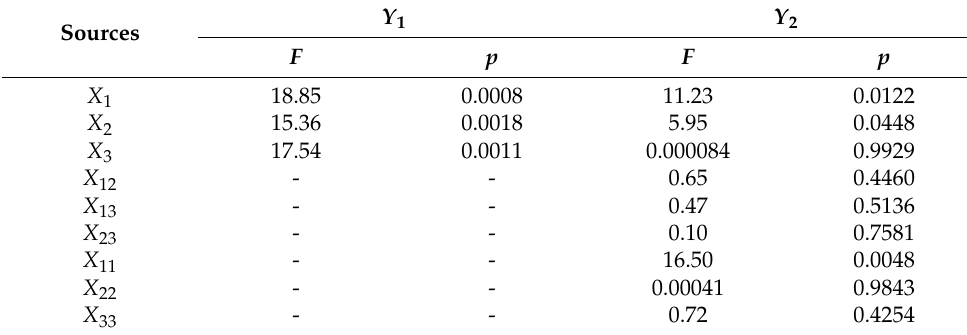
Table 5. ANOVA results for independent